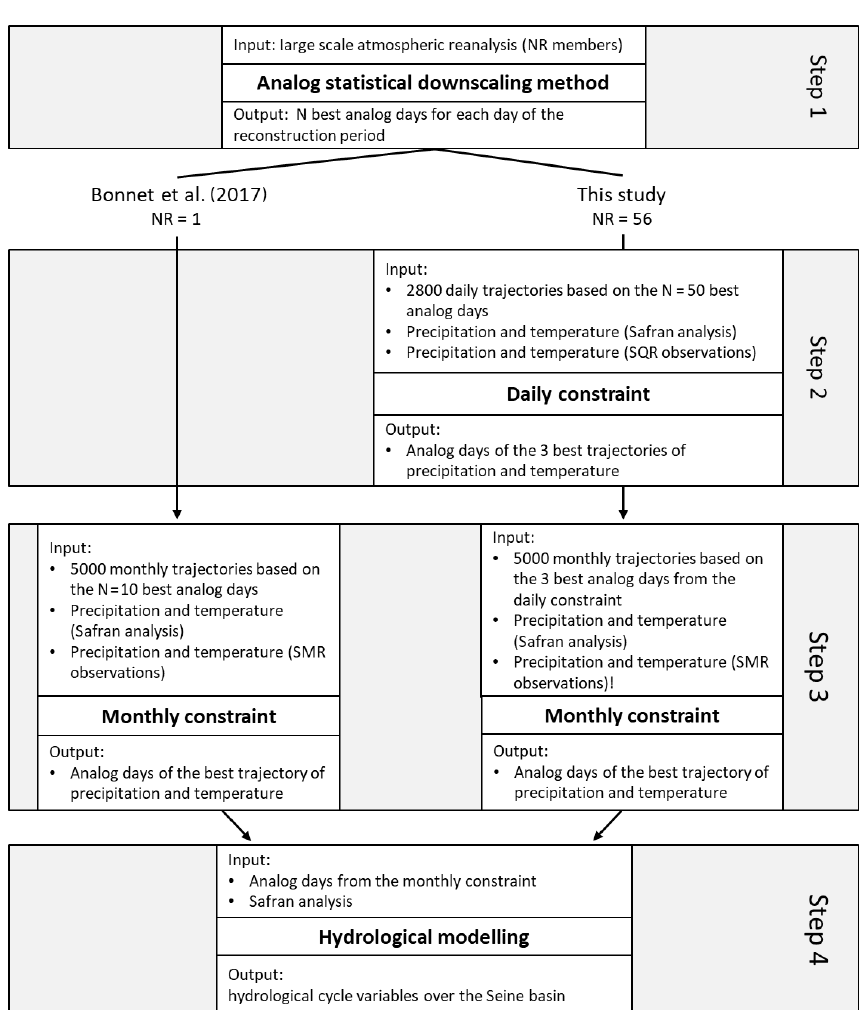
Figure 2. Schematic representation of (on the right) the method used to obtain the hydrological reconstruction in this study and (on the left) the method used in Bonnet et al. (2017), which does not include a daily constraint (Step